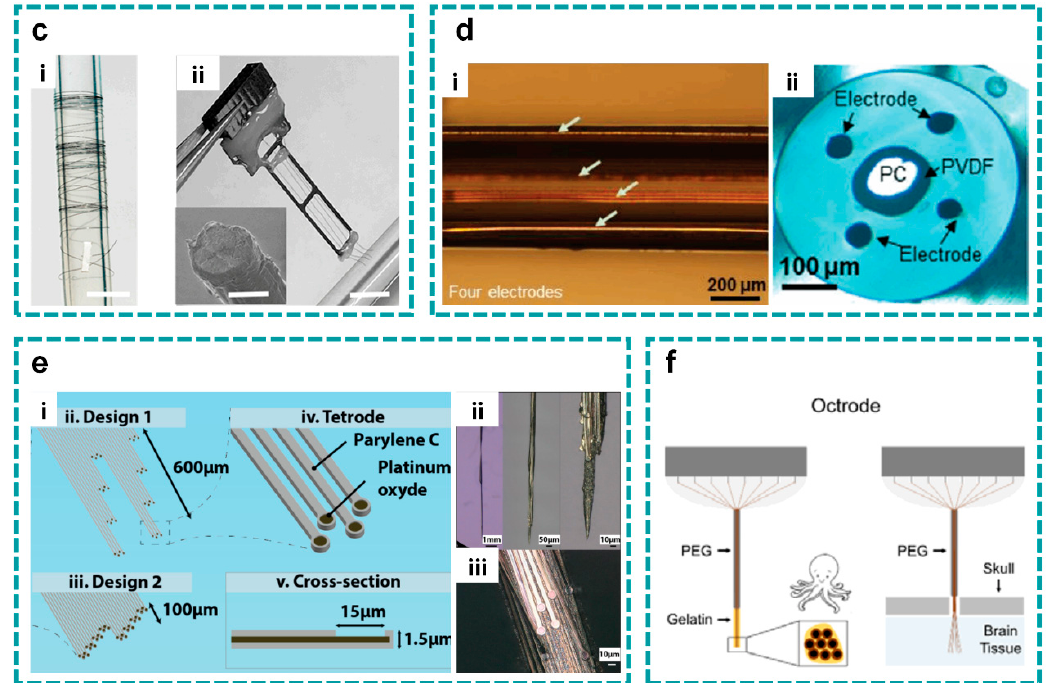
Figure 5. Micro-wire layout. ( a ) a graphene encapsulated copper (G-Cu) microwire electrode to avoid the toxicity of copper for direct implantation (reprinted with permission from [41].); ( b ) graphene microwires with unique mechanical and electrochemical properties (reprinted with permission from [76].); ( c ) a soft and MRI compatible implantable microwire electrode based on the carbon nanotube fibers; i: scale bar, 5 mm; ii: scale bar, 5 mm. Inset, SEM image of a CNT fiber electrode tip; scale bar, 10 µm (reprinted with permission from [99].); ( d ) a composite flexible multimode microwire probe composed of metal electrodes and double-clad waveguides (reprinted with permission from [100].); ( e ) NeuroRoots as microwire layout with similar dimension to neurons, mechanical flexibility and spatial distribution (reprinted with permission from [83].); ( f ) the self-expanding octopus-like microwire electrode array (reprinted with permission from [101].).